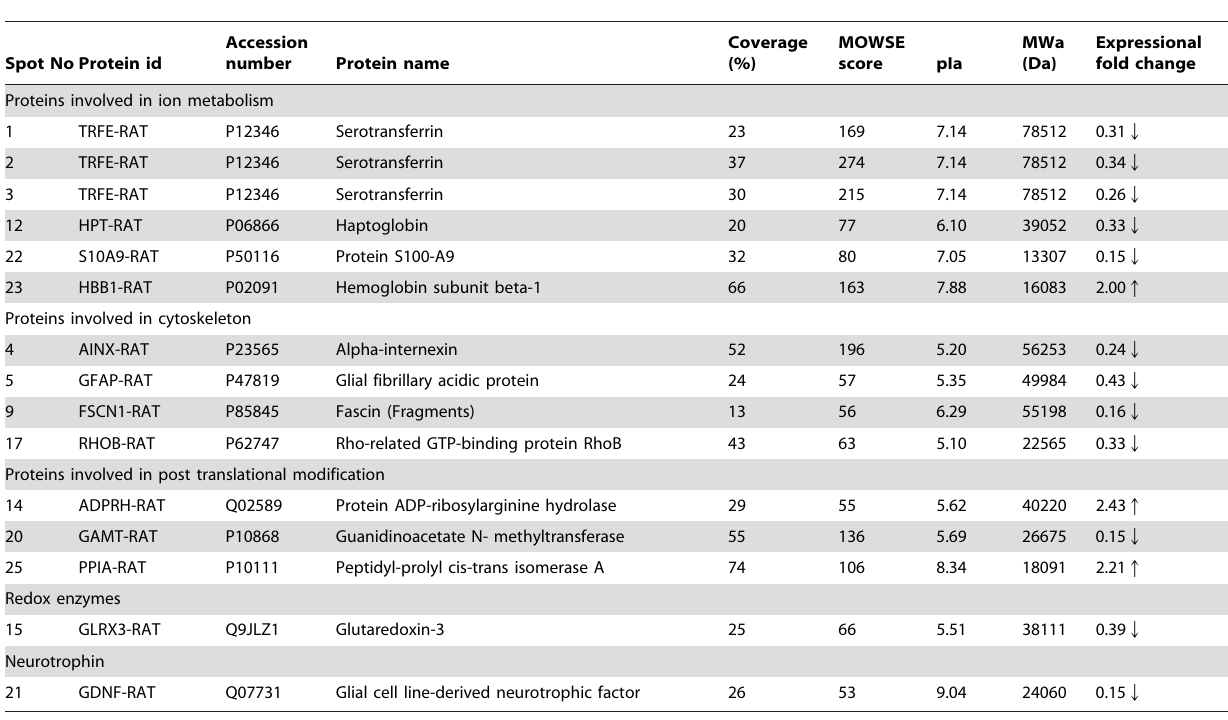
Up-arrows = up-regulated. Down-arrows = down-regulated. The % coverage of the analyzed peptides, the score from Mascot searches, the mass and pI (from the database) and Swiss-Prot accession number are shown for each protein. Proteins displaying up-regulation or down-regulation, with an average fold-difference ( P , 0.05) of $ 2-fold between pairs of conditions, are marked ( + ) and ( 2 ), respectively. MALDI-TOF MS result for % coverage of analyzed peptide and the score from Mascot searches. doi:10.1371/journal.pone.0042068.t001 PLoS ONE |